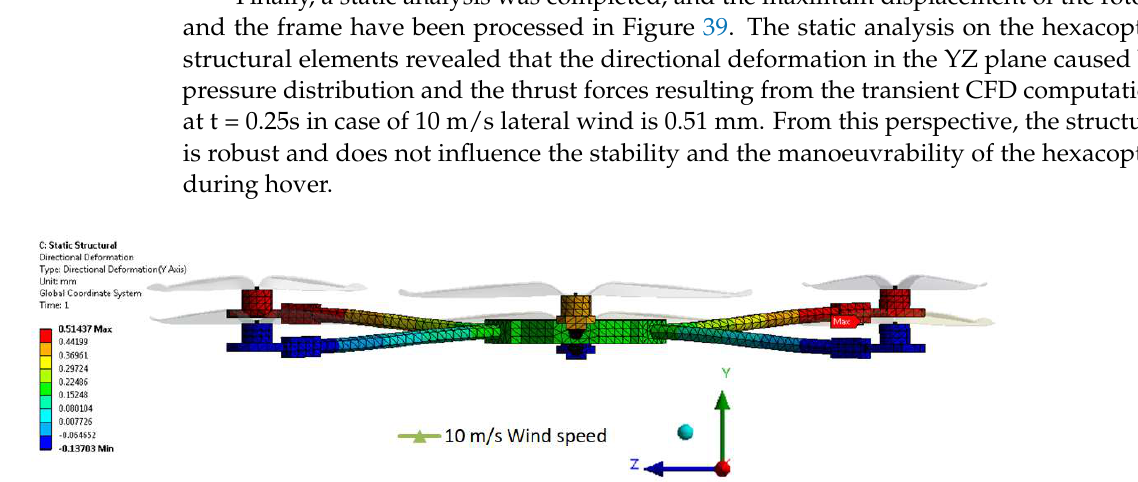
Figure 38. Drag and lift forces -numerical vs. analytic computation.